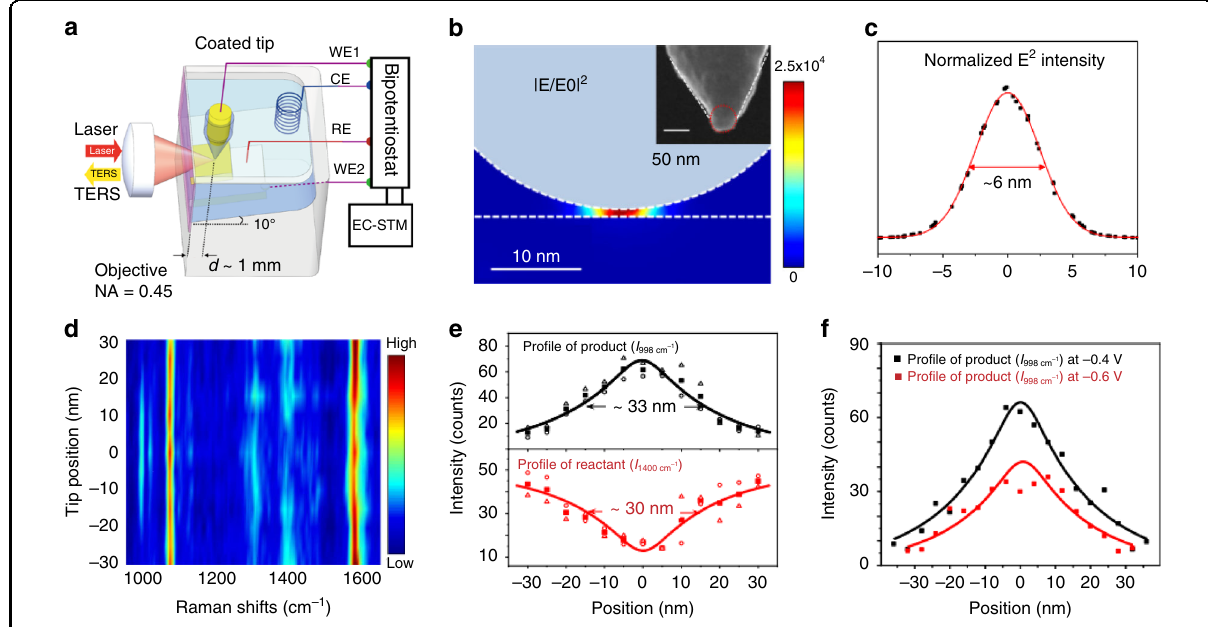
Fig. 12 Macro-optics for EC-TERS. a Schematic illustration of the EC-TERS 105 . b Calculated plasmonic electric fi eld ( E 2 ) distribution when the Ag tip is positioned on the Au surface. Inset: scanning electron microscope image of the Ag tip. c Calculated E 2 pro fi le on the substrate surface in the plasmonic gap. Red line is fi tted using a Gaussian function. d Color-coded intensity map of the line-trace TERS spectra across a reaction region. The reaction was induced at the sample potential of − 0.4 V under a laser power of 0.7 mW. The line-trace TERS spectra were acquired with the sample potential at − 0.7 V. Bias: 100 mV, I tunneling : 800 pA. e Plots of intensities of the 998 cm − 1 peak (top) and 1400 cm − 1 peak (bottom) with the tip position. The open triangle, circle symbols represent the intensities in the trace and retrace spectra. The solid square symbols represent the average intensities of the trace and retrace spectra. f Pro fi le of the reaction induced at − 0.6 and − 0.4 V for comparison 106